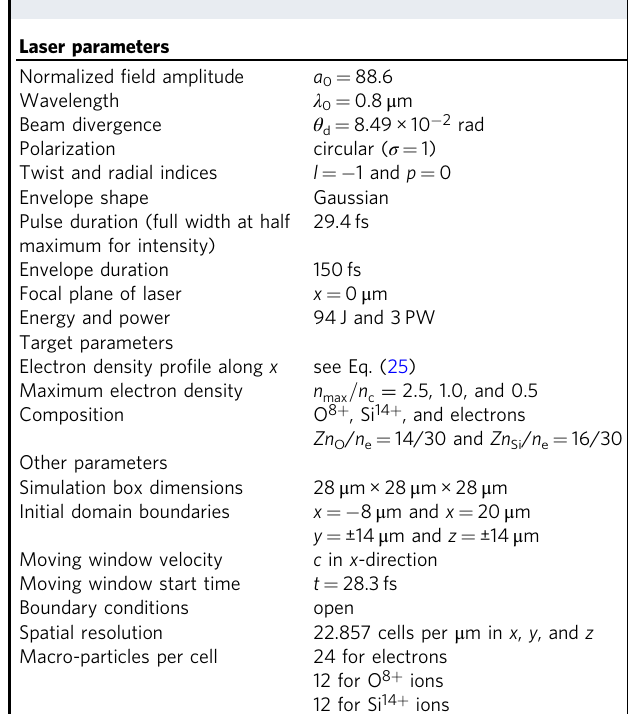
Table 1 3D PIC simulation parameters for cases with normal laser